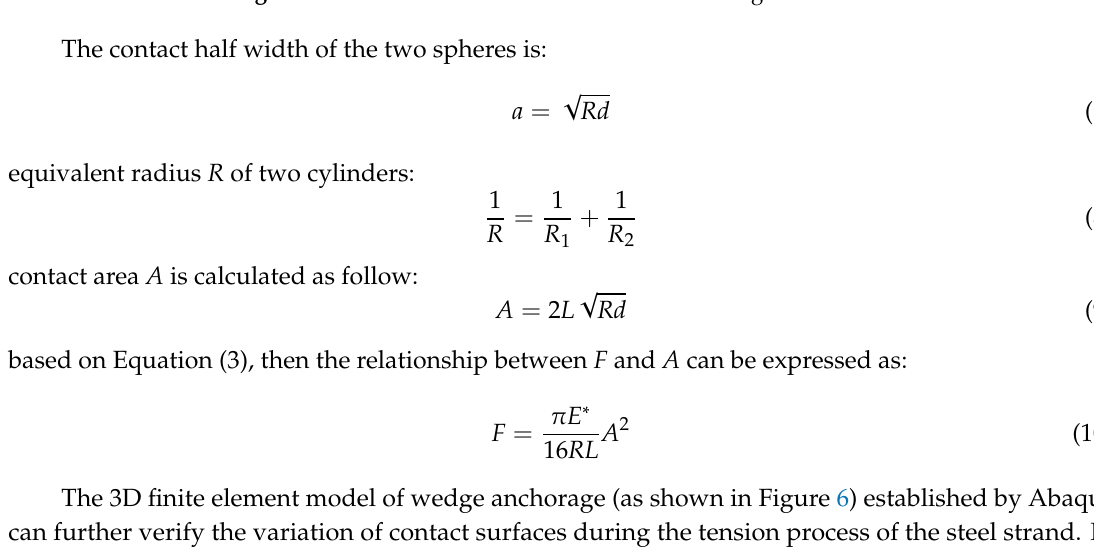
Figure 5. Parallel contact of two cones between wedge and barrel.